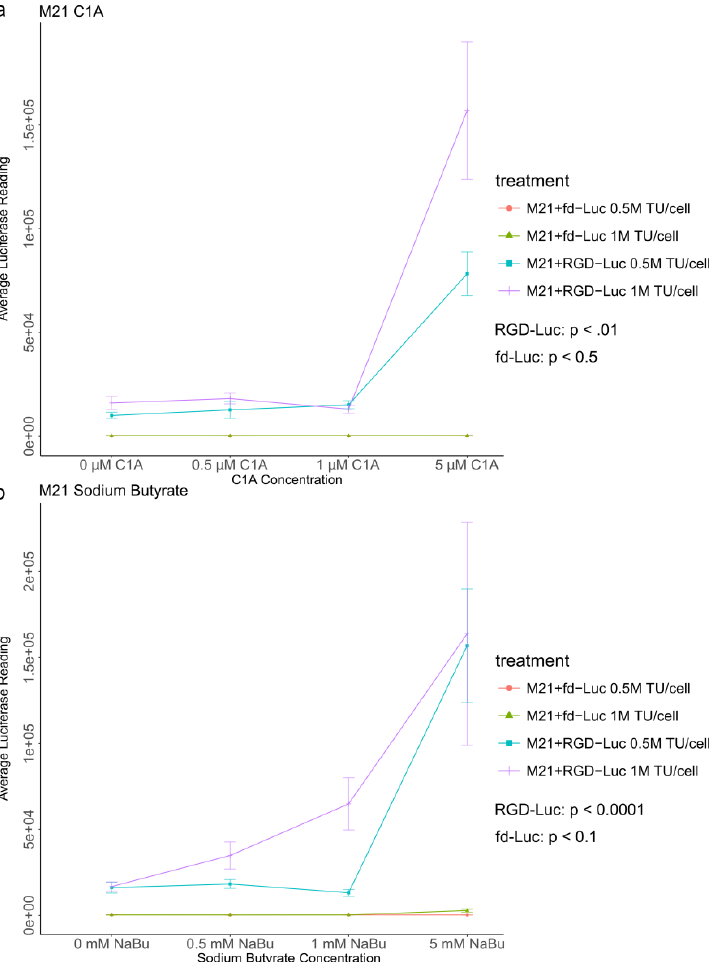
Figure 4. Luciferase assays with targeted AAVP (RGD-Luc) and non-targeted AAVP vectors (fd-Luc) expressing a luciferase ( Luc ) reporter gene at two different amounts of transduction with AAVP, 5 × 10 5 and 1 × 10 6 transducing units (0.5 million (M) TU/cell and 1 million (M) TU/cell, respectively). ( a ) M21 cells at day 4 post vector transduction, cultured with increasing concentrations of C1A. Transgene expression was dependent on targeting and increased both with dosage of C1A and AAVP TU. ( b ) M21 cells at day 4 post vector transduction and cultured with sodium butyrate (NaBu). Transgene expression was dependent on targeting and increased with dosage of sodium butyrate and with increasing AAVP TU. Experiments were carried out in triplicates and repeated twice. The vertical bars indicate standard deviation.